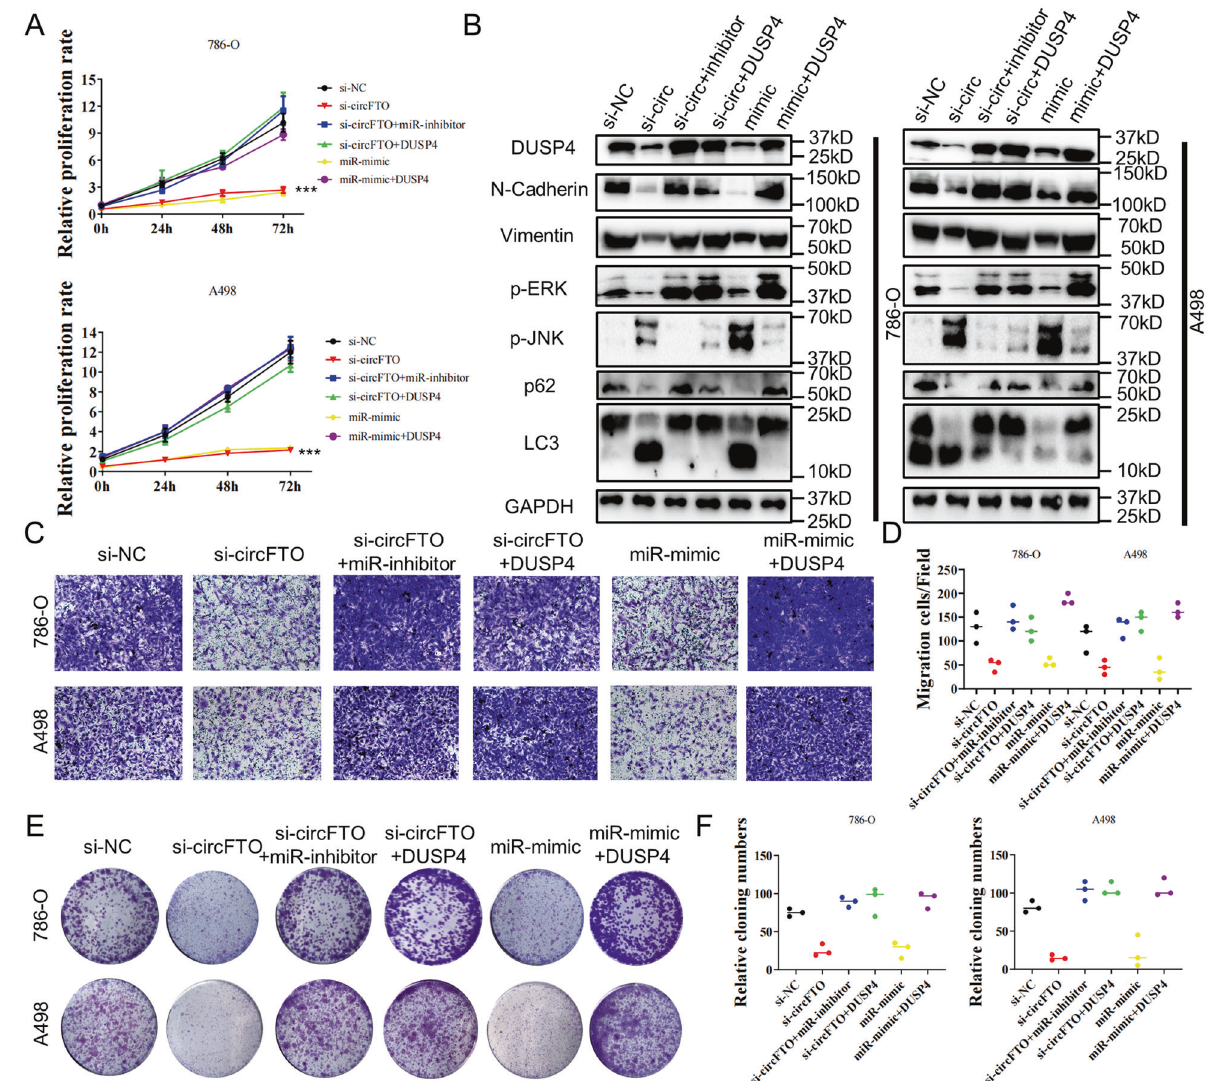
Fig. 5 circFTO promoted the proliferation and migration of ccRCC cells via miR-514-3b/DUSP4 axis in vitro. A CCK8 assay were used to identify proliferation of si-NC/si-circFTO transfected 786-O and A498 cells with miR-mimic, miR-inhibitor and/or DUSP4 overexpression. B Western Blot results of core proteins level in si-NC/si-circFTO transfected 786-O and A498 cells with miR-mimic, miR-inhibitor and/or DUSP4 overexpression. C and D Transwell assay used to show the migration ability of si-NC/si-circFTO transfected 786-O and A498 cells with miR- mimic, miR-inhibitor and/or DUSP4 overexpression. E and F Colony formation assay were used to identify proliferation of si-NC/si-circFTO transfected 786-O and A498 cells with miR-mimic, miR-inhibitor and/or DUSP4